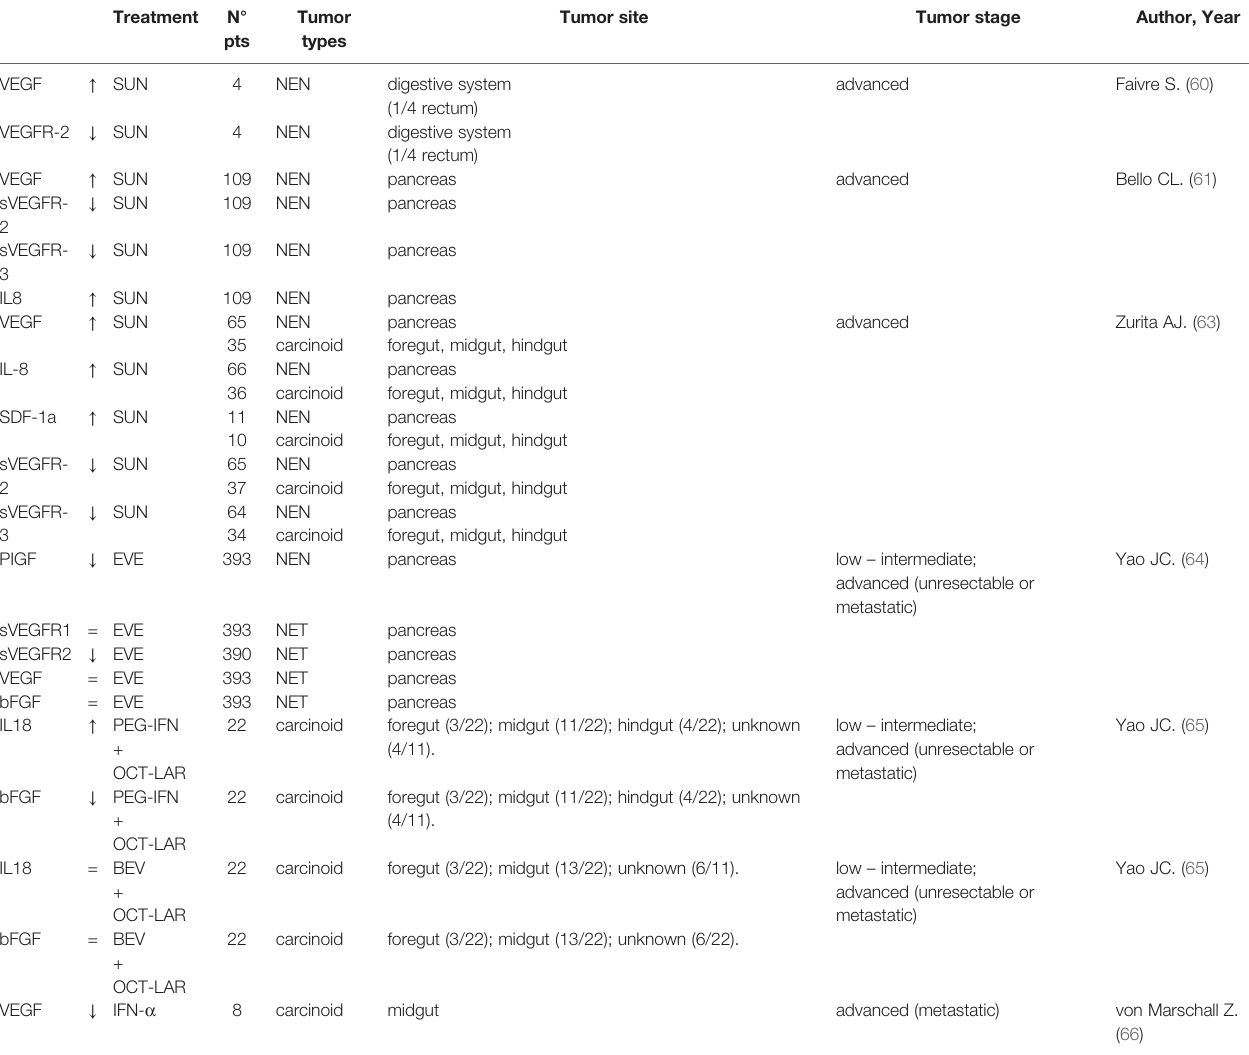
TABLE 2 | Circulating cytokines trend according to different treatments.